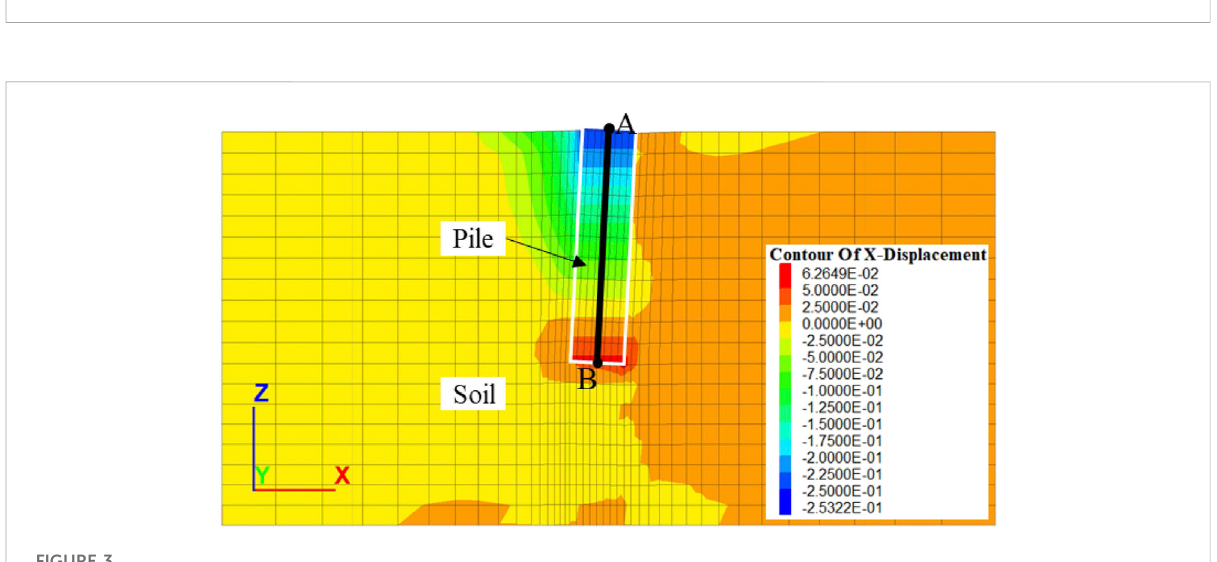
FIGURE 3 Contour of x -displacement for the reference